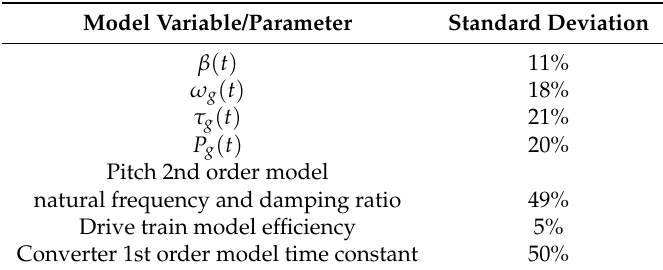
Table 5. Wind turbine uncertain